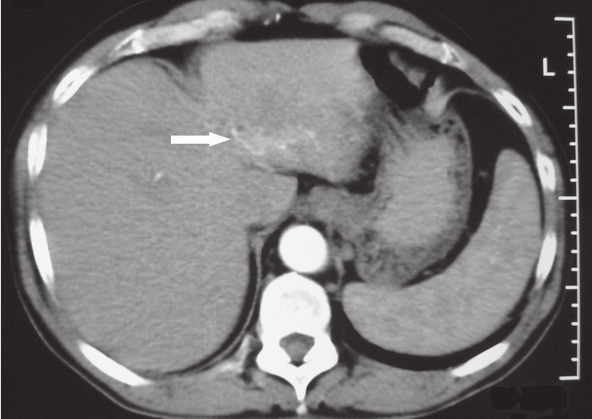
Figure 3. Computed tomography of the abdomen shows a focal perfusion abnormality in the left lobe of the liver (arrow).